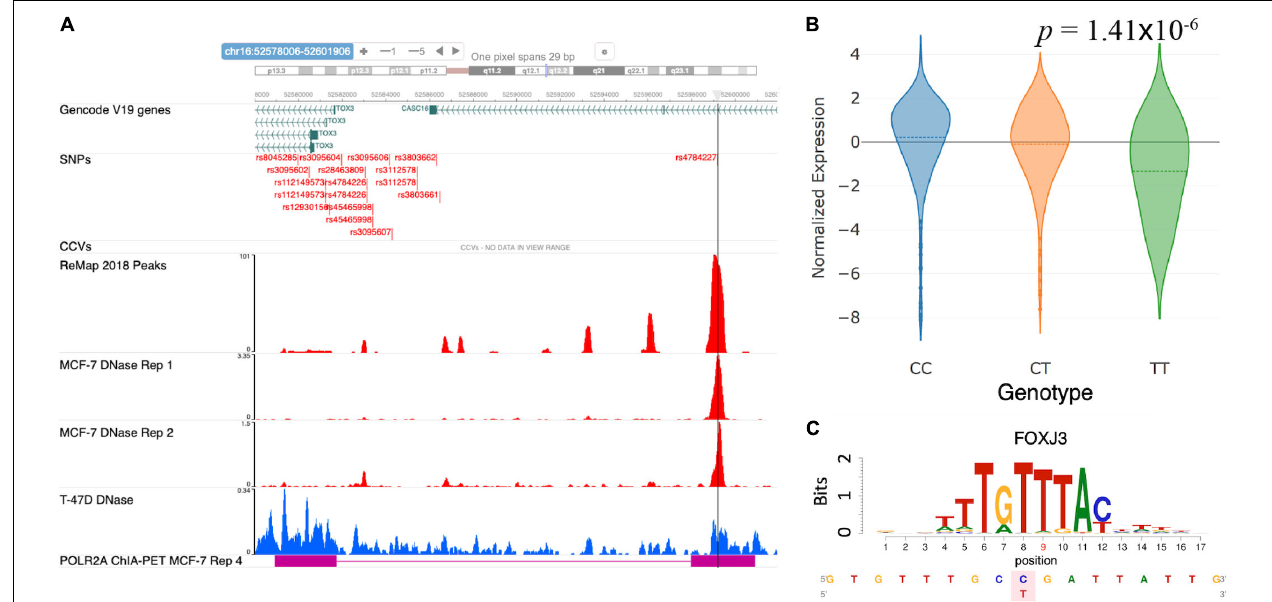
FIGURE 4 | Case study of GWAS locus at TOX3 : (rs4784227, TOX3 , FOXA1). (A) Embedded genome browser showing the SNP rs4784227 within an open chromatin region (MCF-7 DNase tracks) and several TF peaks (“ReMap 2018 Peaks”). (B) eQTL plot showing significant correlation between TOX3 expression and